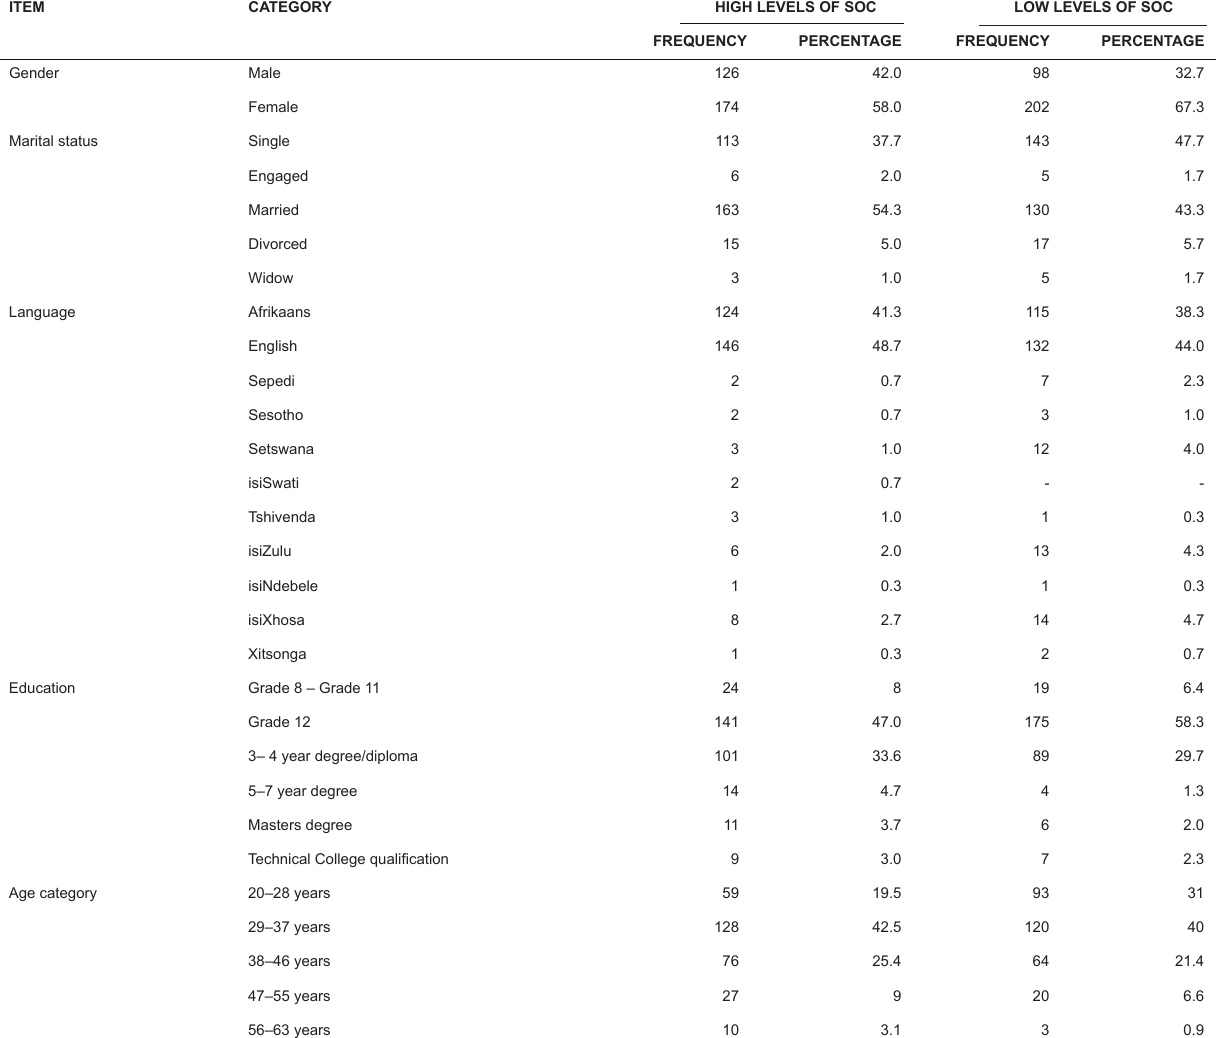
taBLe 2 Demographic characteristics of the participants with high and low levels of sense of